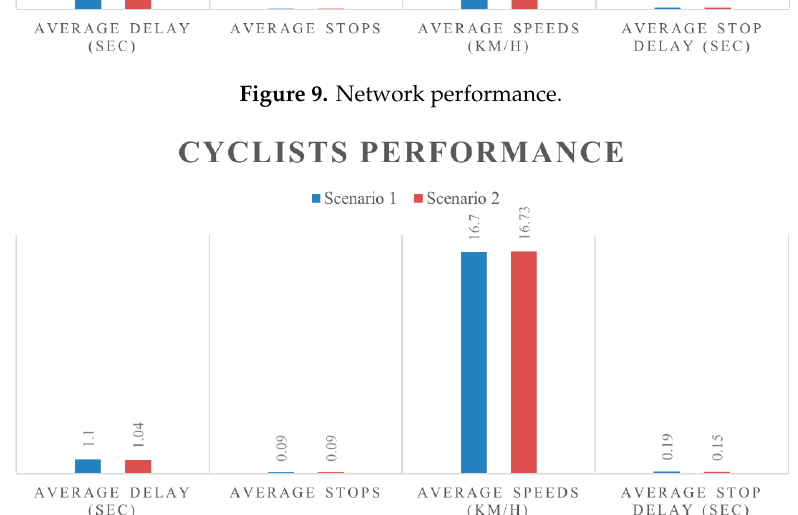
Figure 10. Cyclists’ performance.